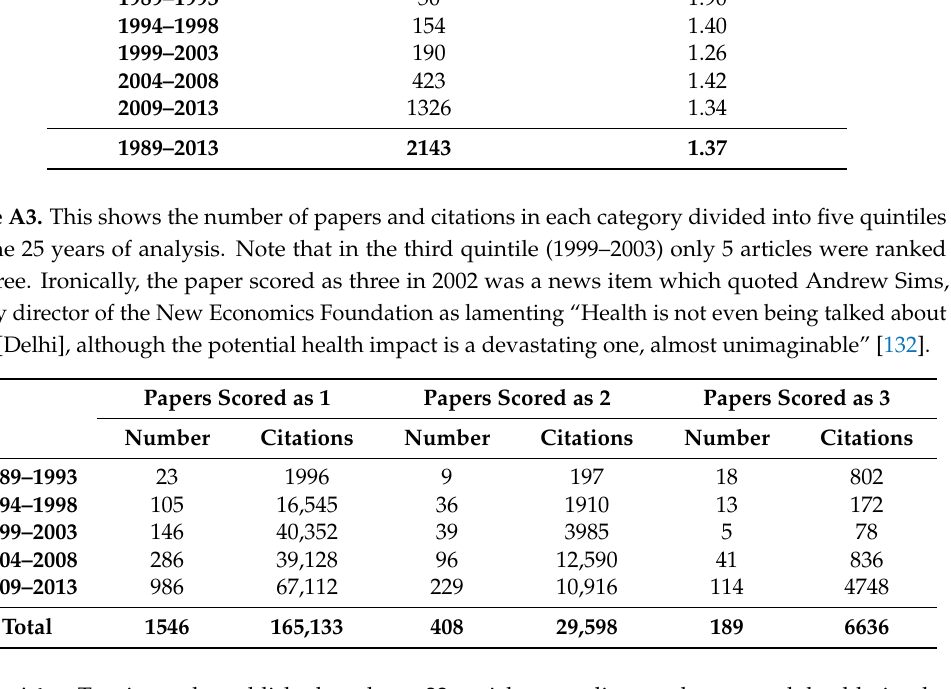
Ten journals published at least 22 articles on climate change and health in the period